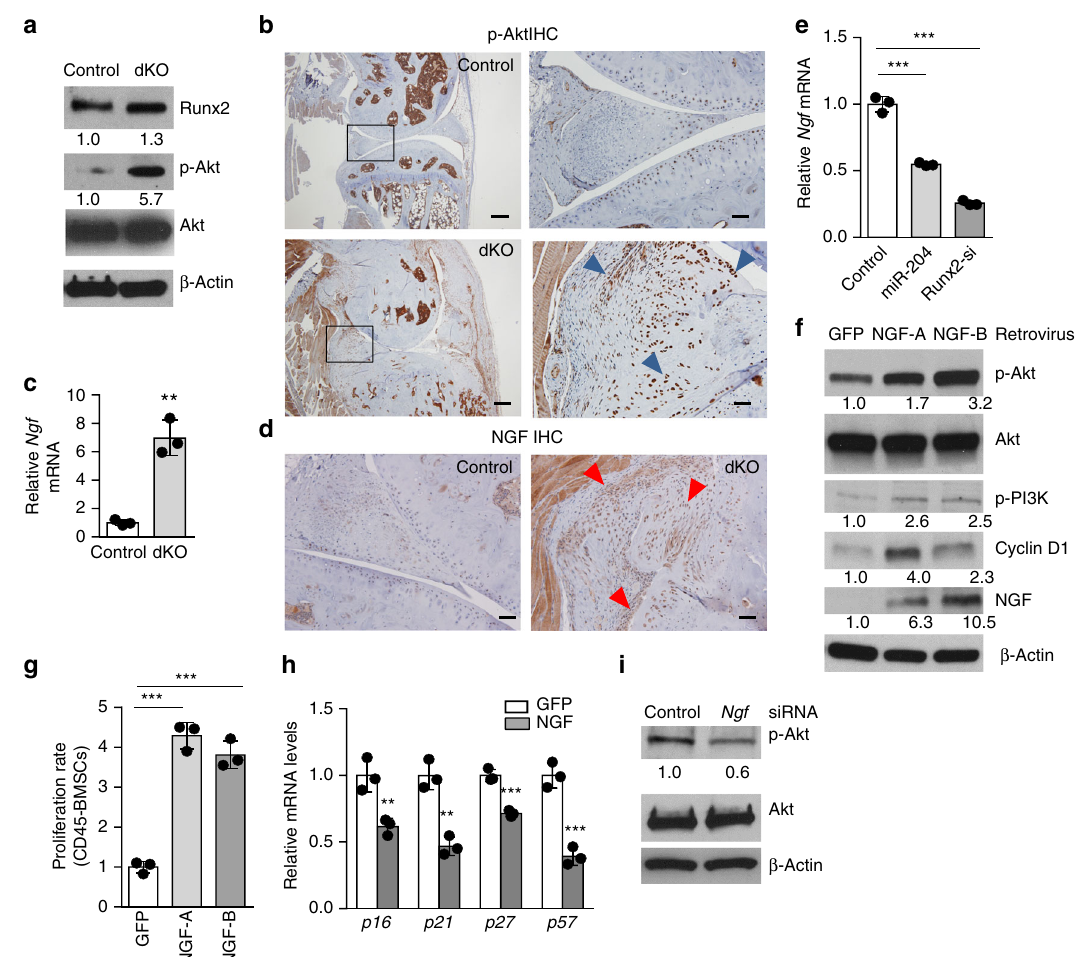
Fig. 5 The miR-204 / -211 -Runx2 axis in regulation of NGF-Akt signaling and mesenchymal progenitor cell proliferation. a Western blot analysis shows activated Akt signaling in dKO CD45 - BMSCs. The numbers below the blot indicate the relative levels of the denoted protein (except p-Akt normalized to total Akt, all proteins were normalized to β -actin) in each group compared to the control. n = 3. b IHC results of p-Akt in control and dKO mice. Blue arrowheads mark p-Akt-positive cells. Scale bar, 250 μ m (left) or 50 μ m (right). c qRT-PCR analysis of Ngf mRNA expression in CD45 − BMSCs from control or dKO mice. ** P < 0.01, unpaired Student ’ s t test. n = 3. d IHC results of NGF in control and dKO mice. Red arrowheads, NGF-positive cells. Scale bar, 50 μ m. e qRT-PCR analysis of Ngf mRNAs shows that miR-204 or Runx2 siRNA decreases Ngf expression in CD45 − BMSCs. *** P < 0.001, one-way ANOVA followed by the Tukey − Kramer test. n = 3. f Retroviral overexpression of two NGF isoforms in CD45 − BMSCs from WT mice activates Akt signaling as shown by western blot. n = 3. g NGF overexpression increases proliferation of CD45 − BMSCs determined by cell number counts. *** P < 0.001, one-way ANOVA. n = 3. h qRT-PCR analysis of CDK inhibitors in mouse CD45 − BMSCs with GFP or NGF overexpression. ** P < 0.01, *** P < 0.001,